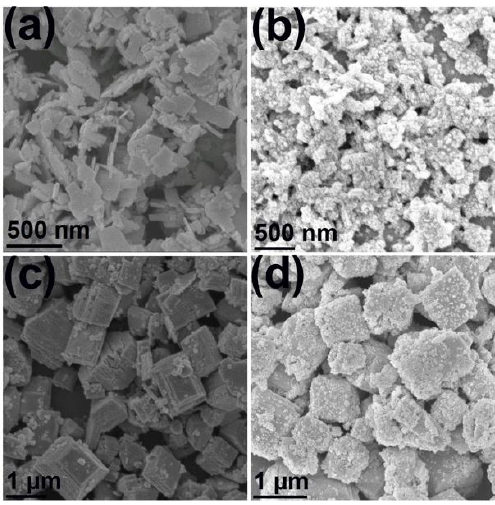
Figure 5. The SEM images of ( a ) BFCTO-1.0;( b ) BFCTO-1.0/NGF;( c ) BFCTO-2.0 and BFCTO-2.0/NGF samples.